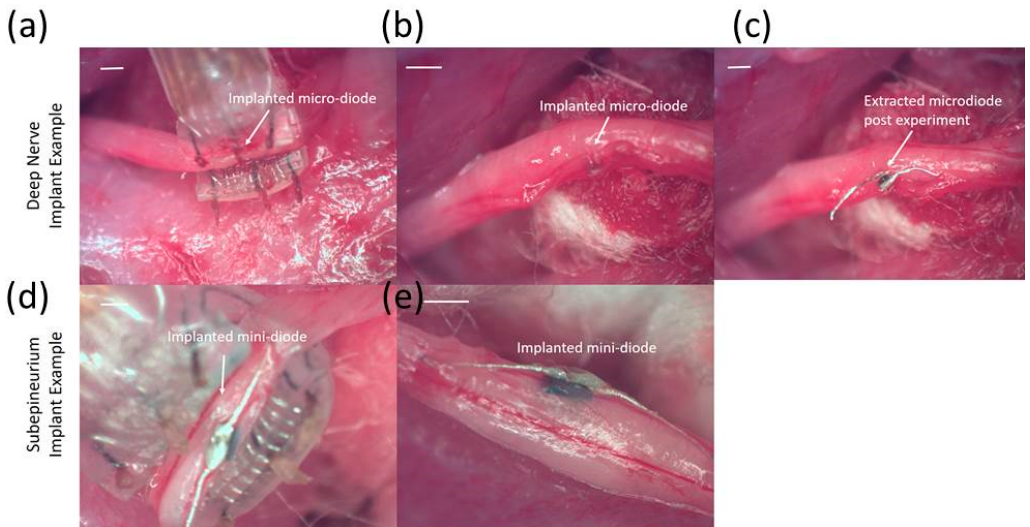
Figure 12. Representative images of implanted micro- and mini-diodes. ( a – c ) represent an example of a diode with a 220 µm feature size and lead lengths to match the length of the cuff implanted deep inside the nerve. ( d , e ) show an example of a diode with 0.5 mm feature size with 3 mm long leads, the entirety of which is implanted subepineurally.